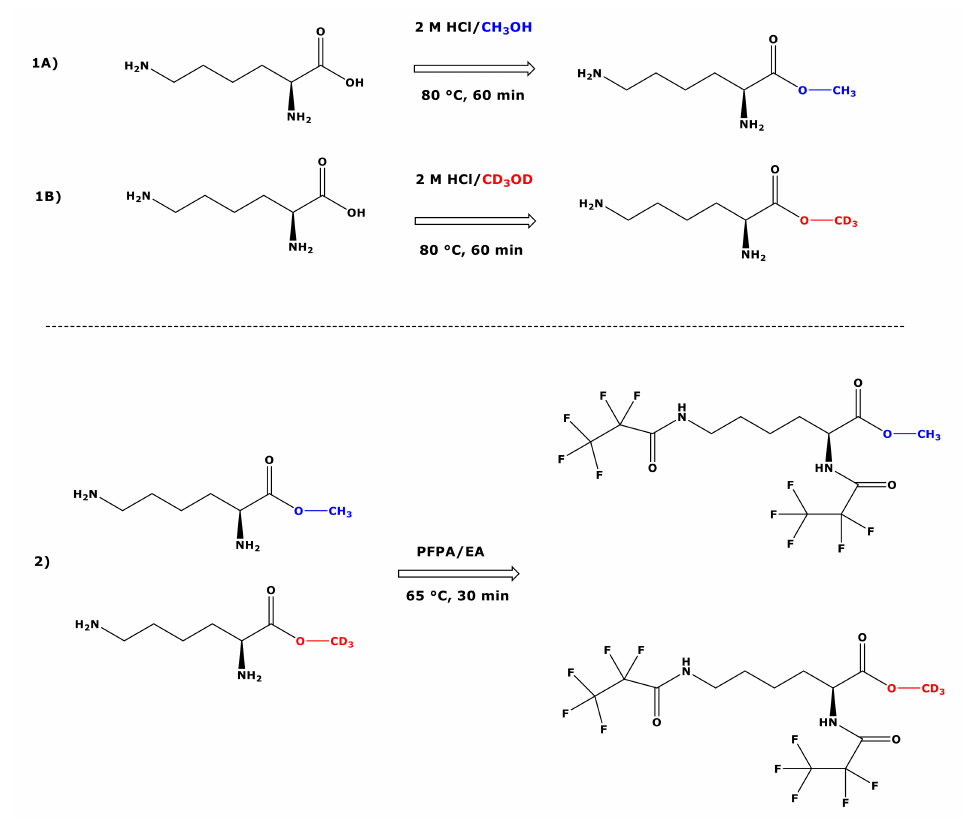
Scheme 2. Two-step derivatization of lysine representative of the chemical class of amino acids. Separate esterification with 2 M HCl in CH 3 OH for biological amino acids ( 1A ) and with 2 M HCl in CD 3 OD for synthetic amino acids ( 1B ) to serve as internal standards. ( 2 ) Combined acylation with pentafluoropropionic anhydride (PFPA) in ethyl acetate (EA; 1:4, v / v